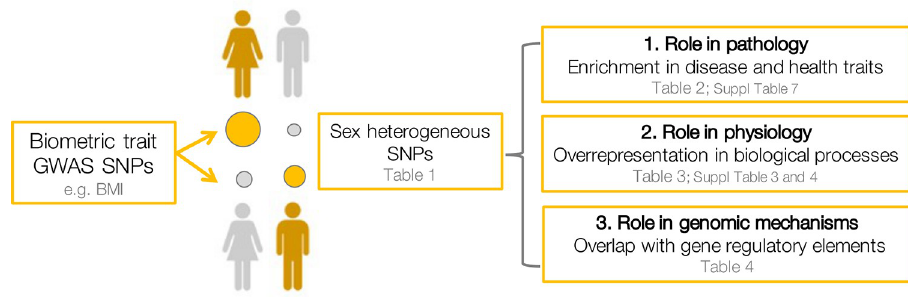
Fig 1. Outline of the presented analyses. We selected a set of sex-heterogeneous SNPs differentially influencing biometric traits. 1) Enrichment of sex-het SNPs in quantitative risk factors and diseases to define a role of sex- heterogeneity in physiology and pathology. 2) Overrepresentation analysis (ORA) of proximal genes assigned to sex- het SNPs in pathways, biological processes and cellular components. 3) Overlap of sex-het SNPs with regulatory elements, predicted eQTLs, and